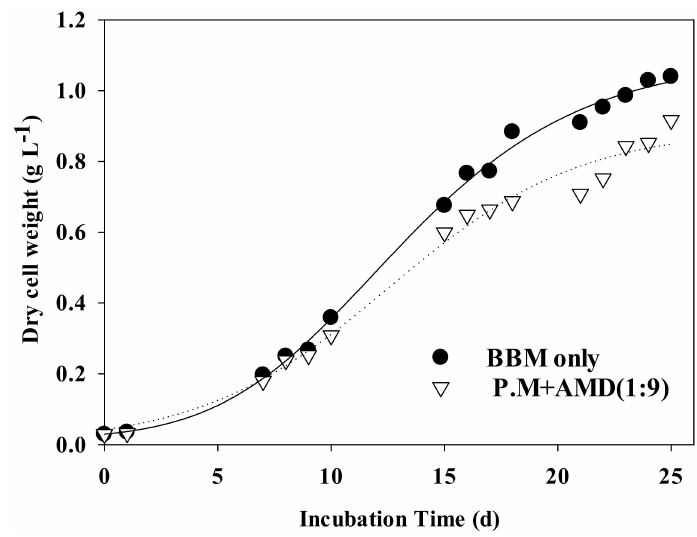
Figure 7. Time courses of biomass concentration for Uronema sp. KGE 3 cultivated in Bold’s Basal Medium (BBM). with pretreated piggery wastewater by membrane (PPWM) + acid mine drainage (AMD) (1:9) medium during Pipes inserted microalgae reactor (PIMR) operation for 25 days.